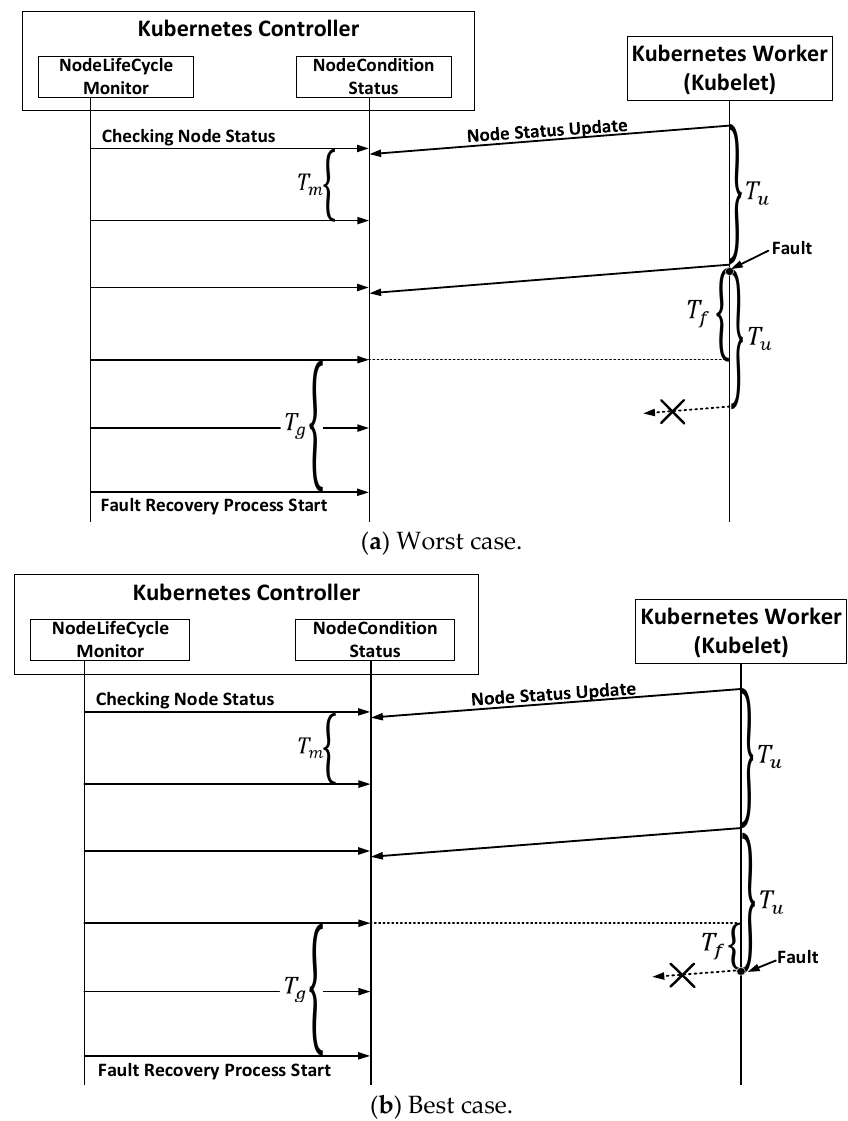
Figure 1. Timing diagrams of the fault detection process.